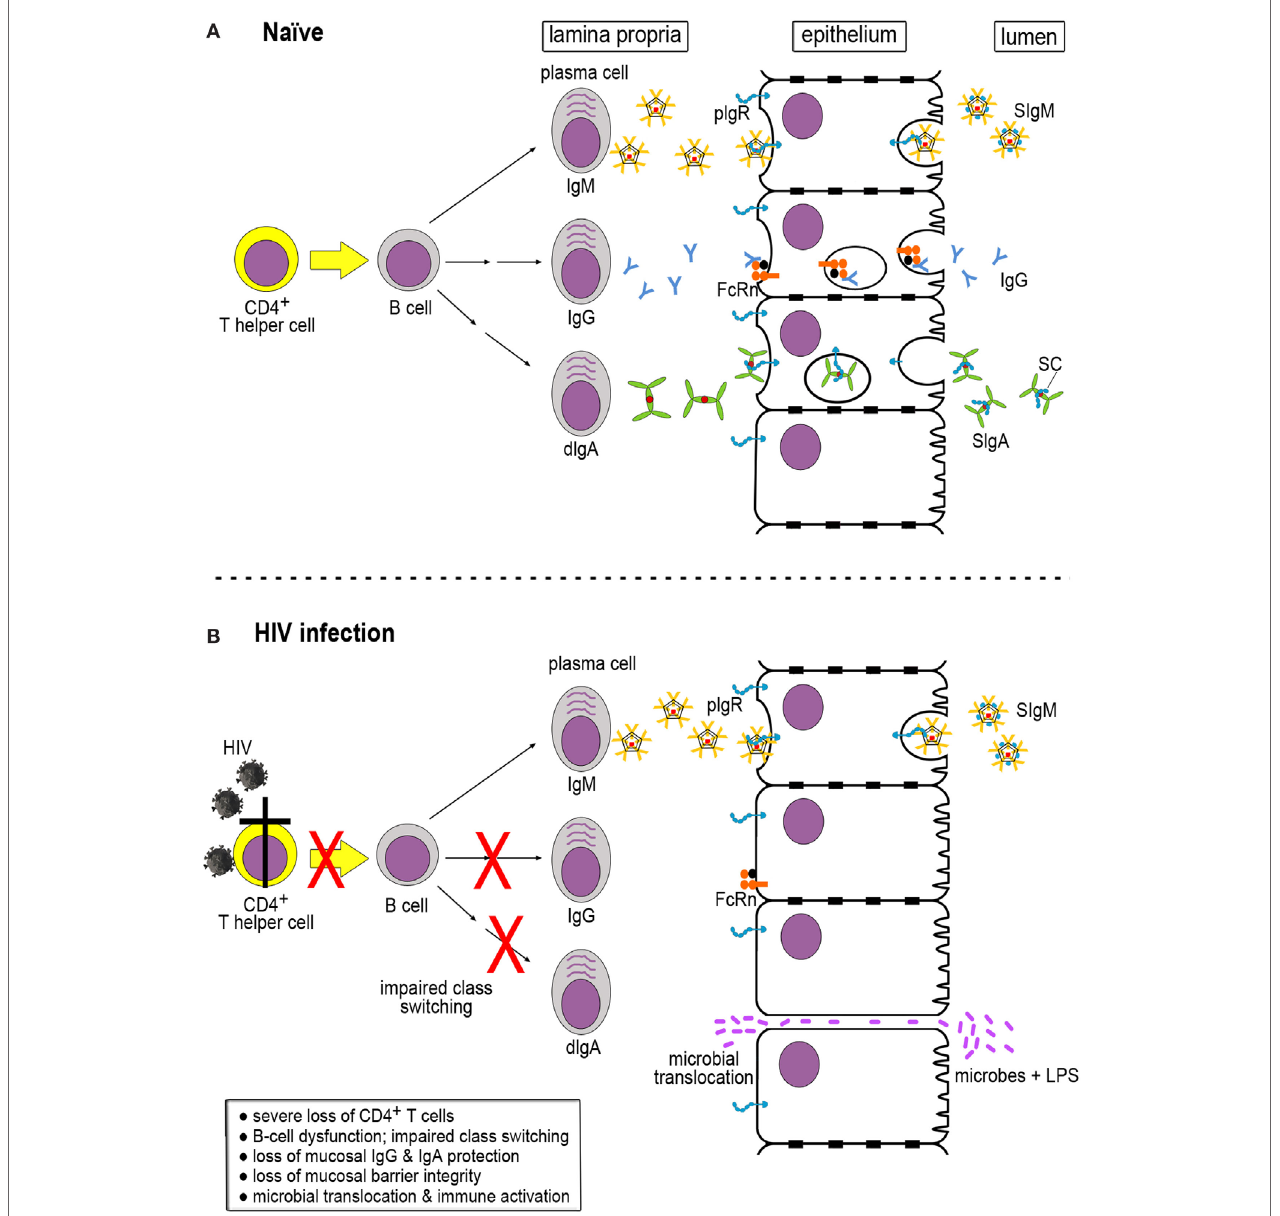
FiGURe 1 | Generation of immunoglobulins (Igs) in naïve and HIV-infected hosts. (A) In a naïve host, multimeric IgM, IgG, and dimeric IgA (dIgA) are produced in the lamina propria by mature plasma cells. The latter are derived from B cells that have received help from CD4 + T cells for Ig class switching. IgM and dIgA interact with the polymeric immunoglobulin receptor (pIgR), which exports the Igs across the epithelial cells. pIgR is cleaved by proteolysis at the luminal side, resulting in the generation of secretory component (SC) that is retained by IgM and dIgA, giving rise to secretory IgM (SIgM) and IgA (SIgM and SIgA, respectively). IgG binds to the neonatal Fc receptor (FcRn) expressed by epithelial cells that transports IgG across to the luminal side. Unlike pIgR, FcRn does not undergo proteolytic cleavage at the luminal side and can shuttle back and forth. (B) During HIV infection, severe loss of CD4 + T cells occurs, resulting in impaired Ig class switching and B-cell dysfunction. As a consequence, IgG and SIgA are markedly decreased in the mucosal compartment. Lack of sufficient mucosal barrier defenses leads to loss of barrier integrity, microbial translocation, and immune